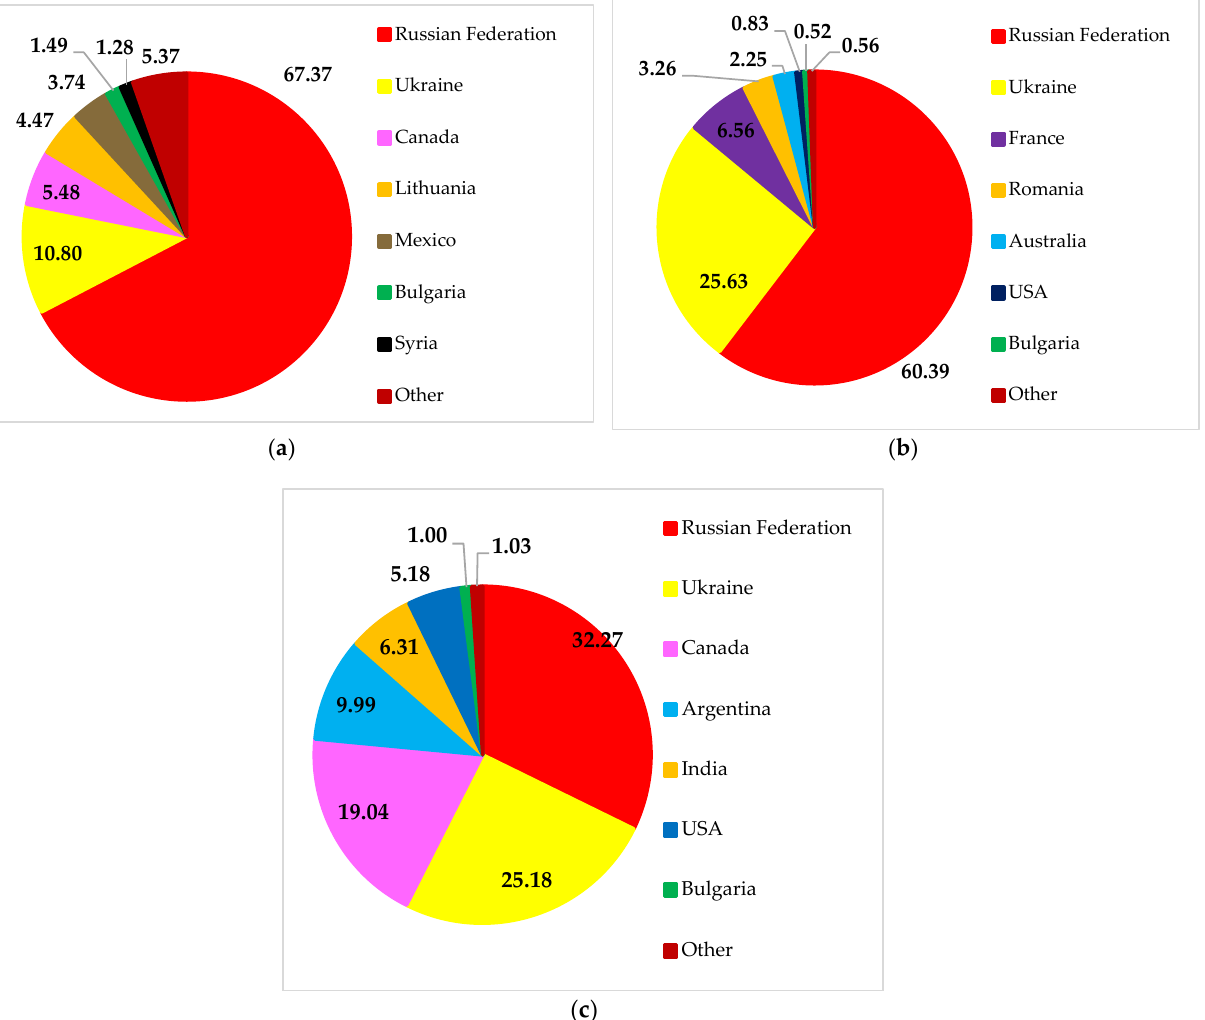
Figure 8. Turkey’s ( a ), Egypt’s ( b ), and Bangladesh’s ( c ) wheat import structure. Source: [30].